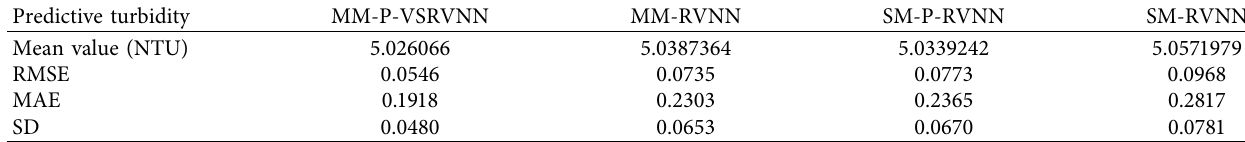
Table 3: Statistics result comparison among four algorithms for predictive turbidity before filtration.